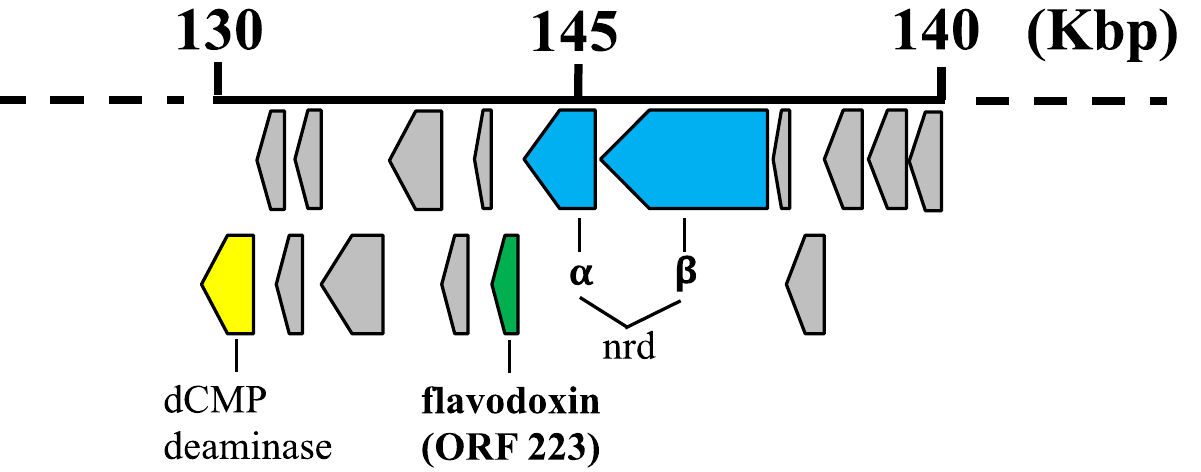
Figure 1. Schematic diagram showing the genomic region of bacteriophage 0305 ϕ 8-36 where the flavodoxin gene is located. The scale is in kilobase pairs. Each arrow represents an individual orf. The flavodoxin gene, colored green, is 0305 ϕ 8-36 ORF number 223. ORFs colored yellow and blue have been tentatively assigned dCMP deaminase and α and β -ribonucleotide reductase (nrd), respectively. Arrows shown in grey represent genes predicted to encode virion proteins of unknown